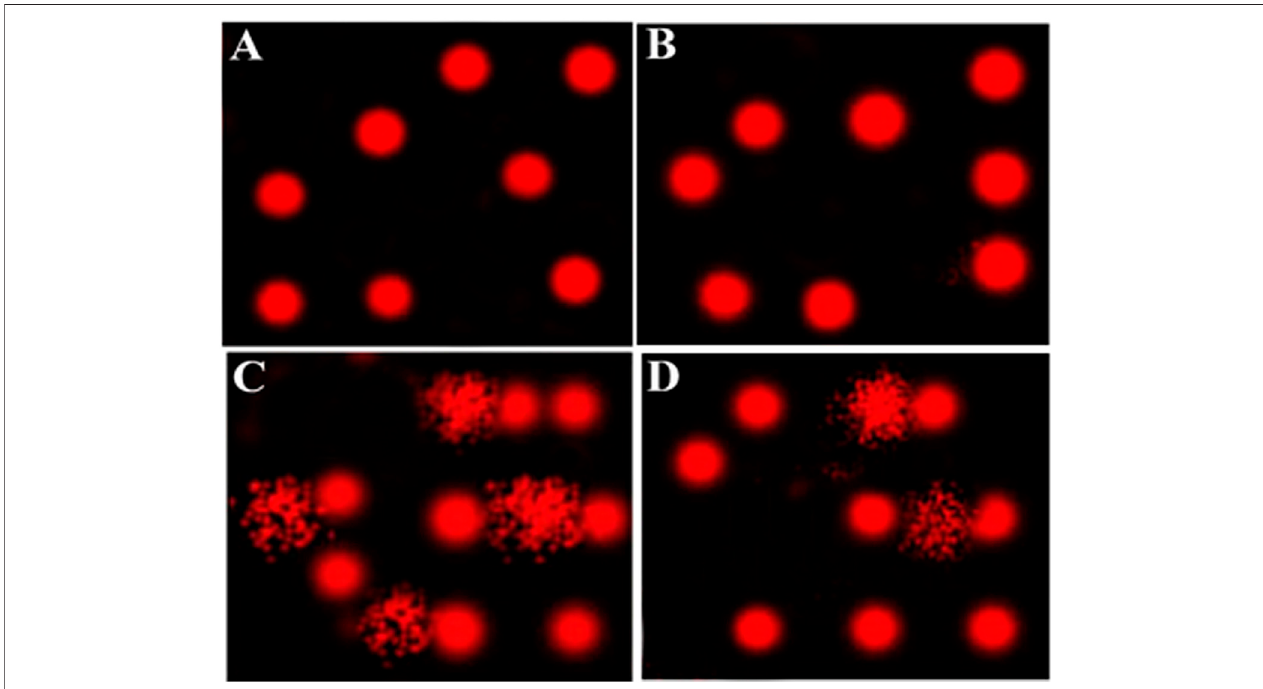
FIGURE1| CometassayforevaluationofhearttissueDNAdamage. (A – D) Control,costus,EST,andEST+costusgroups,respectively.EST,Ehrlichsolidtumor.